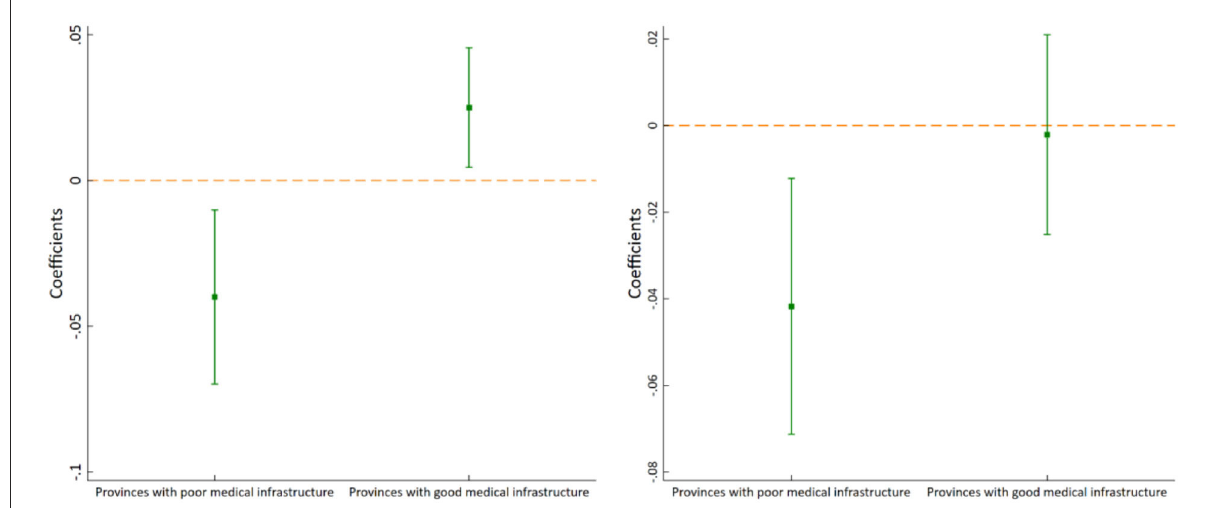
FIGURE6 Regional heterogeneity of ln ME_outpatient (left) and ln ME_inpatient (right) .